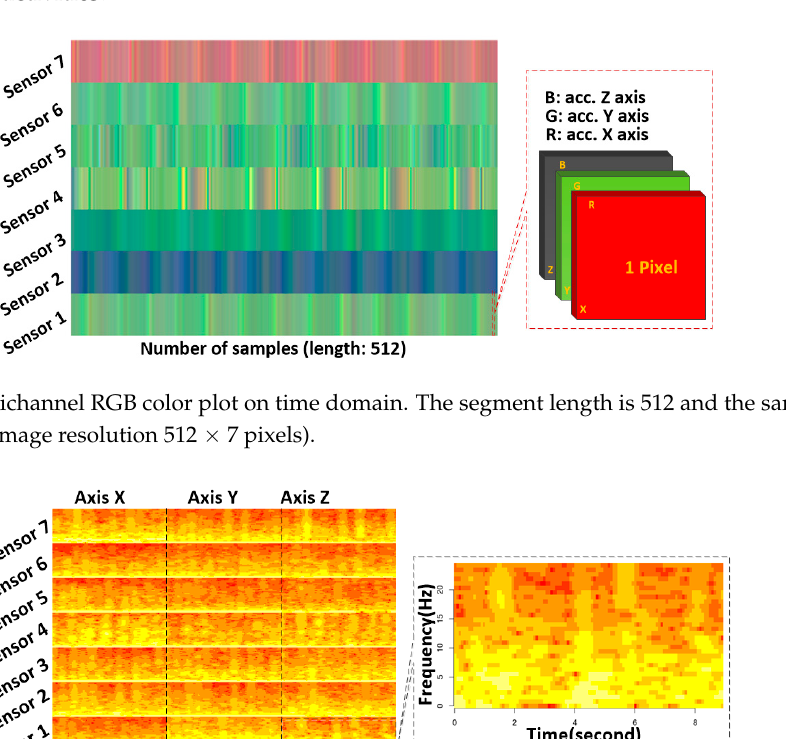
Figure 3. Multichannel RGB color plot on time domain. The segment length is 512 and the sampling rate is 50 Hz (image resolution 512 × 7 pixels).